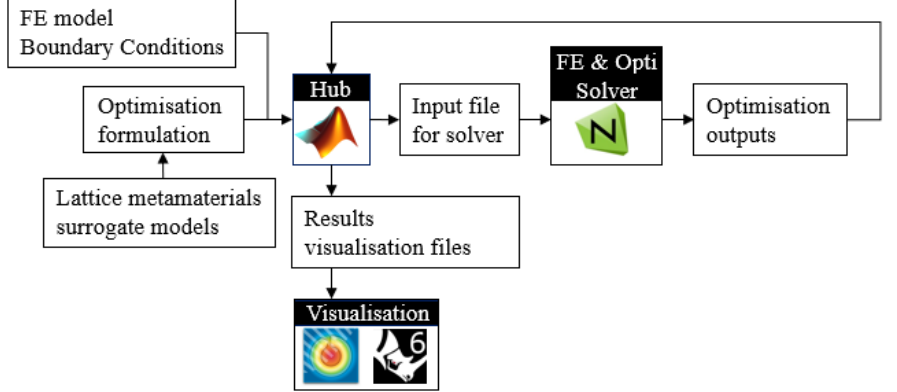
Figure 13. Flowchart of the optimisation platform.